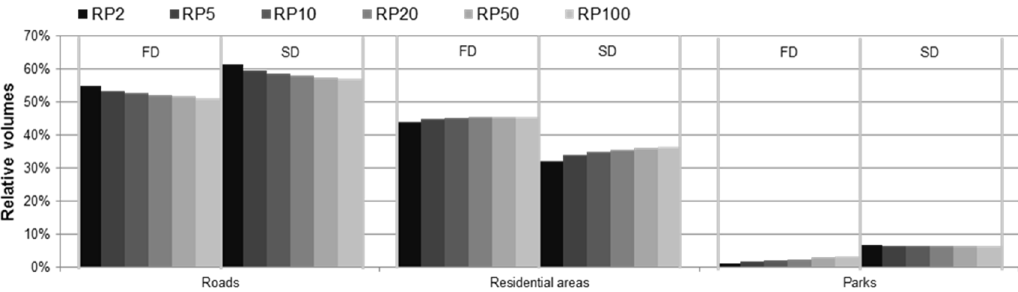
Figure 15. Relative flooding volumes of each land use group for design storms events, Zona Central case study.